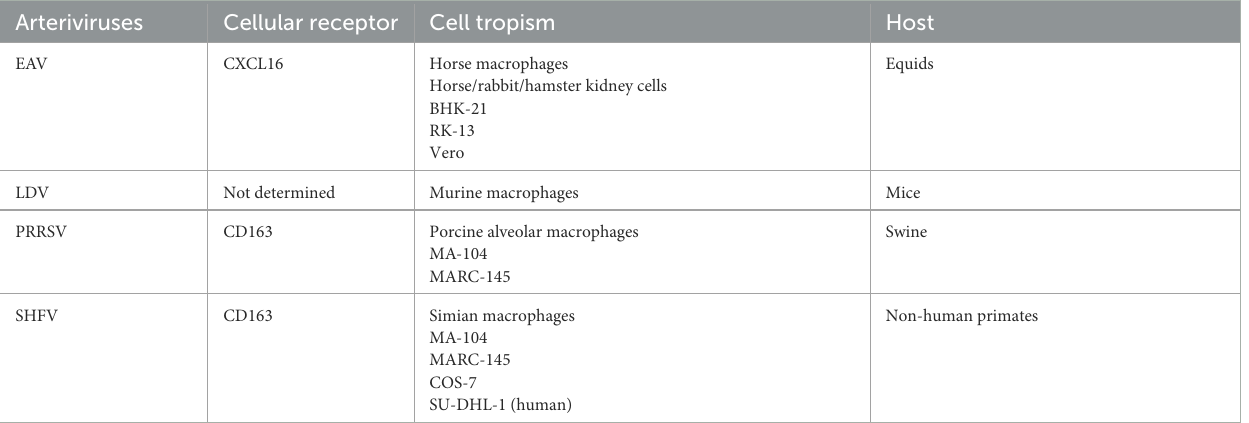
TABLE 1 Overview of cell tropisms and host ranges for